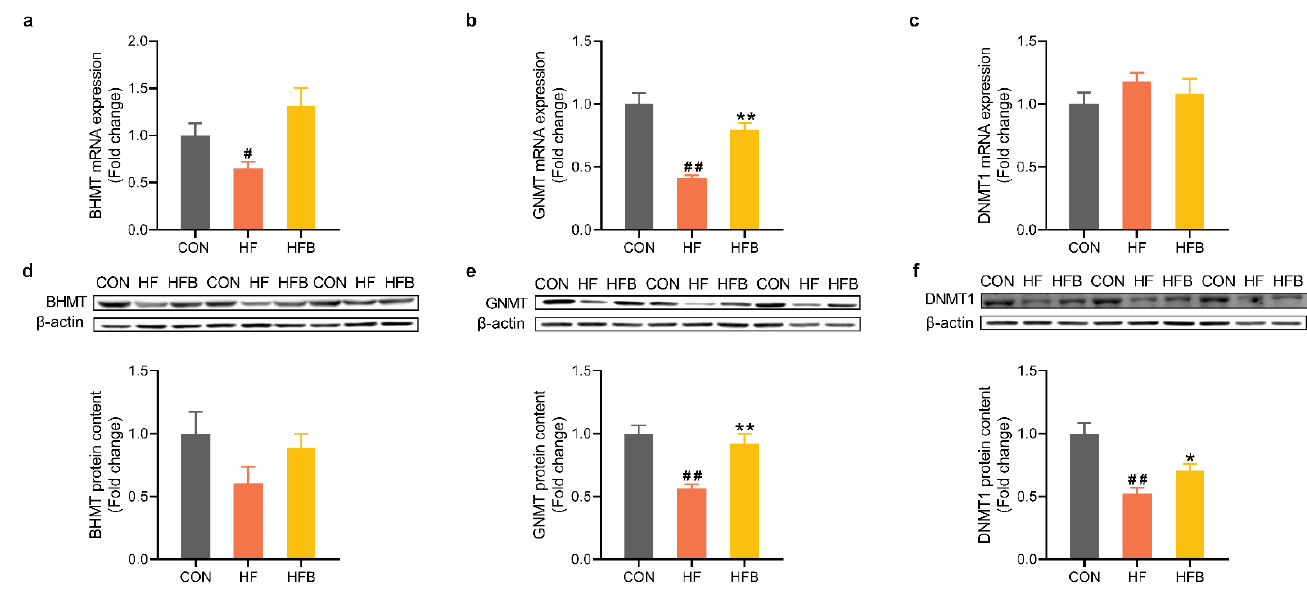
Figure 4. Hepatic genes expression involved in methyl-transfer. ( a ) Hepatic mRNA expression of BHMT ( n = 6). ( b ) Hepatic mRNA expression of GNMT ( n = 6). ( c ) Hepatic mRNA expression of DNMT1 ( n = 6). ( d ) Protein content of BHMT in the liver ( n = 6). ( e ) Protein content of GNMT in the liver ( n = 6). ( f ) Protein content of DNMT1 in the liver ( n = 6). Values are means ± SEM. # p < 0.05 and ## p < 0.01 compared with the CON group. * p < 0.05 and ** p < 0.01 compared with the HF group.